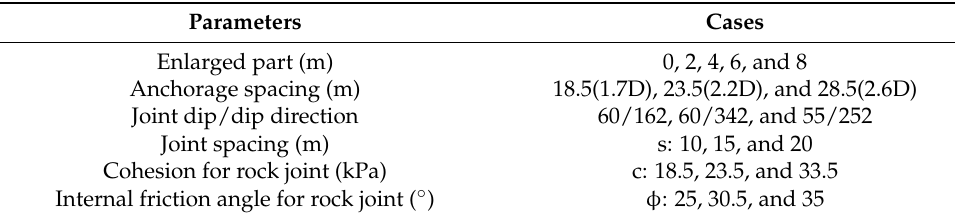
Table 3. Summary of the numerical analyses